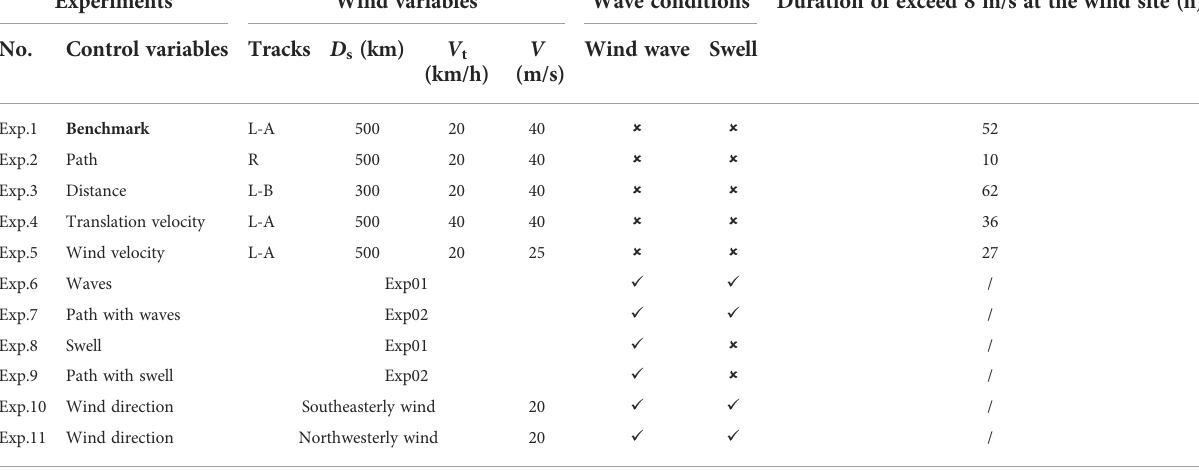
TABLE 2 Setting of numerical